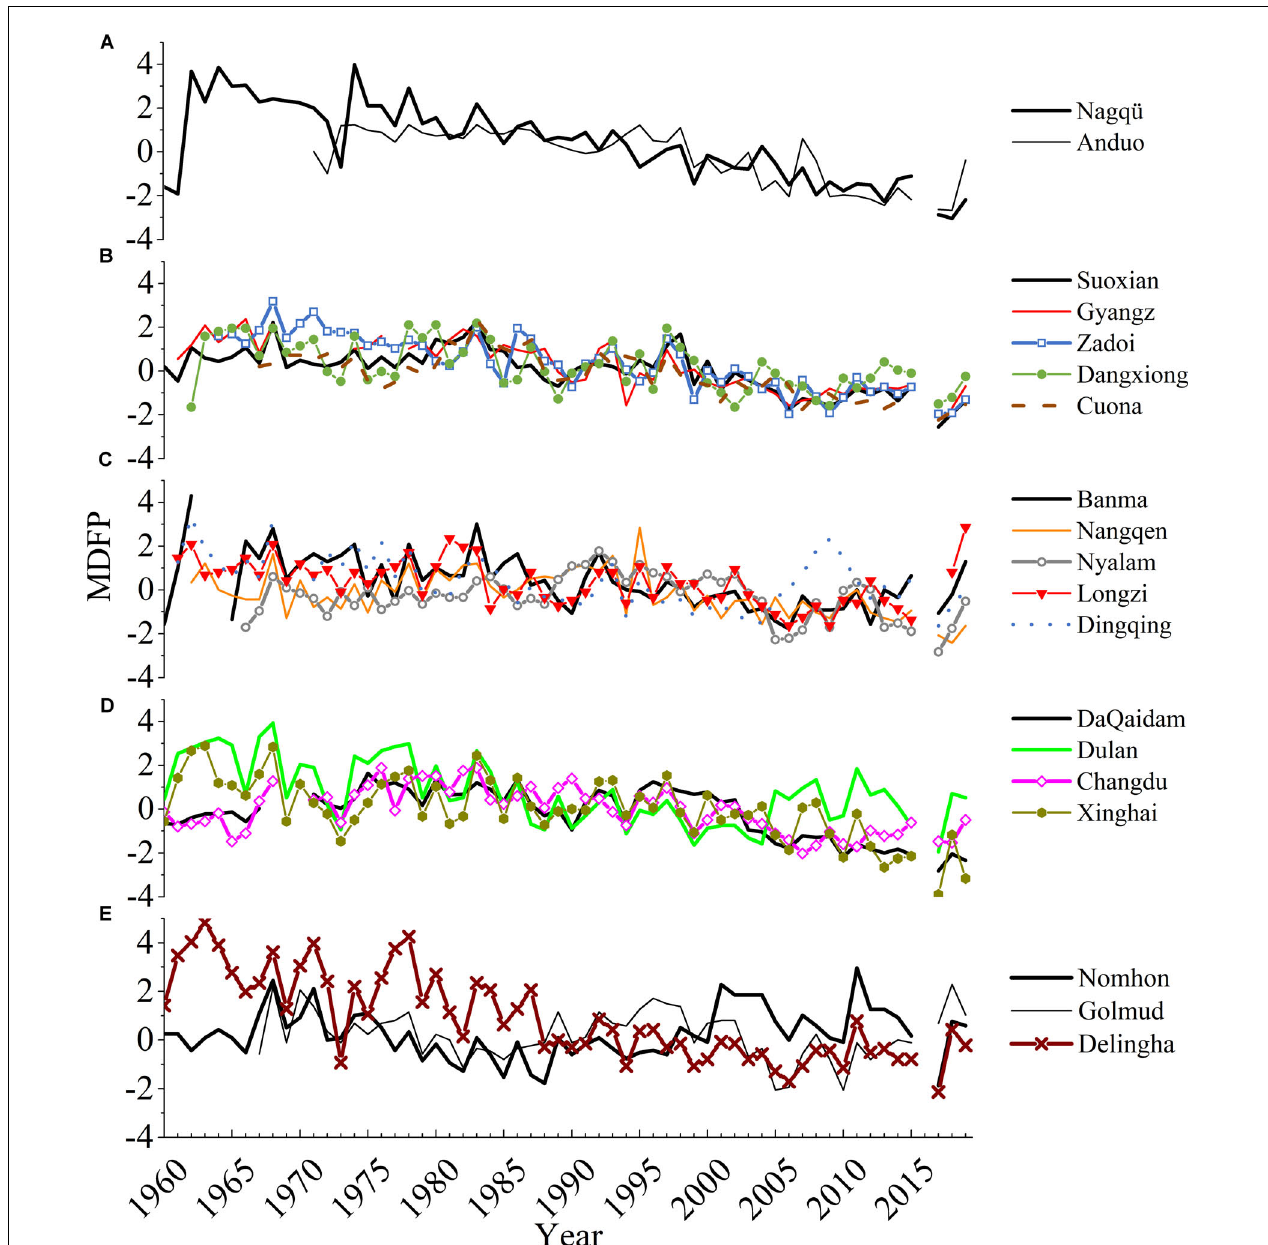
FIGURE 3 | Time series of the maximum depth of frost penetration (normalized relative to 1981–2010) during 1960 to 2019 for (A) stations with the altitude between 4500 and 5000 m, (B) stations with the altitude between 4000 and 4500 m, (C) stations with the altitude between 3500 and 4000 m, (D) stations with the altitude between 3000 and 3500 m, and (E) stations with the altitude between 2500 and 3000